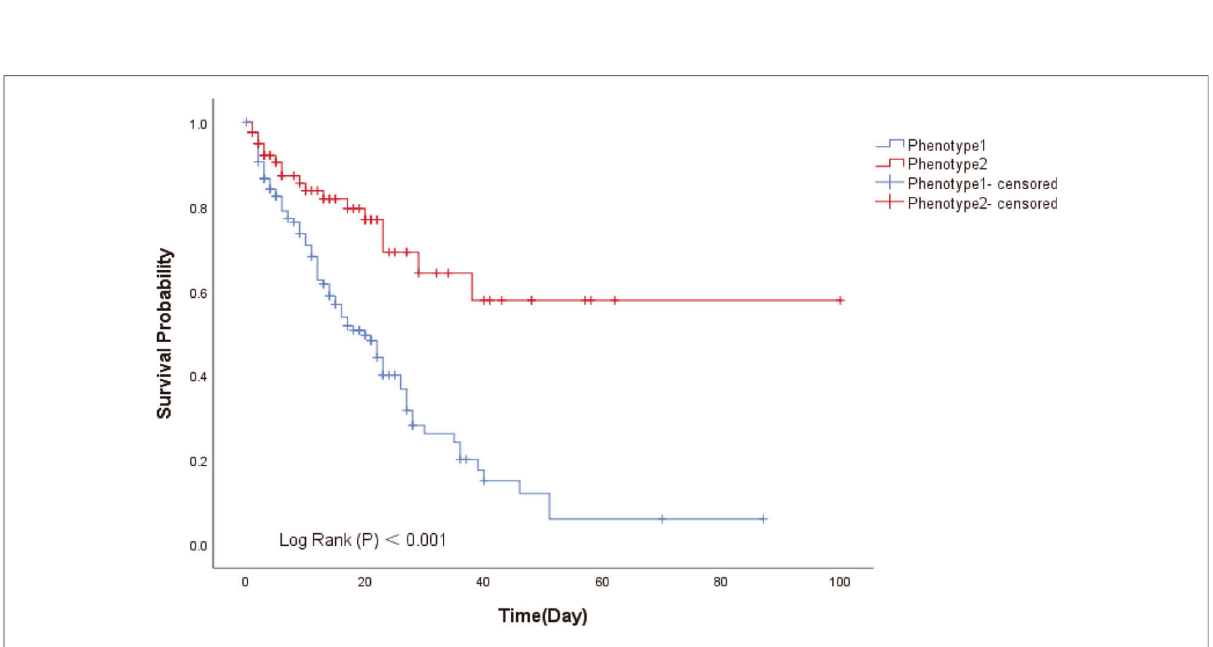
FIGURE 5 Kaplan-Meier curves of different